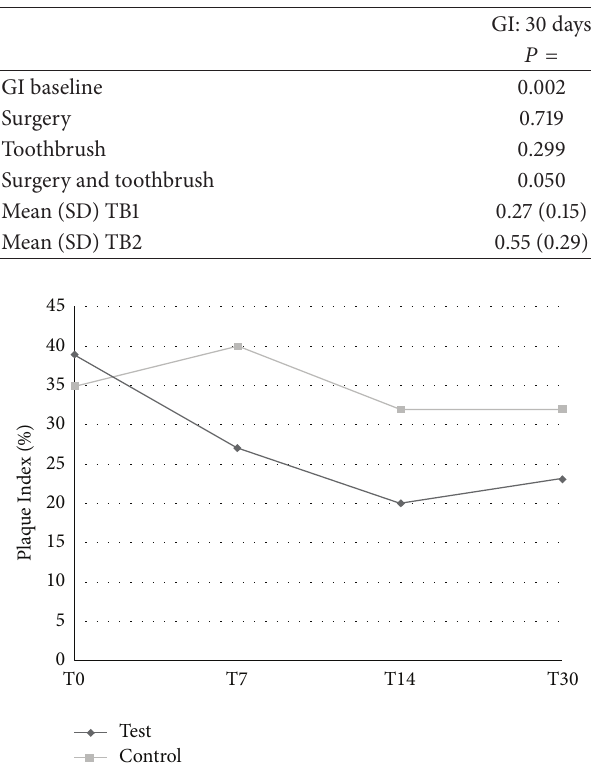
Table 2: Influence of the type of surgery (fixed factor) and of the toothbrush (random factor) on Gingival Index (GI) at 30 days. GI mean values and Standard Deviation (SD) are reported for both test (TB1) and control toothbrushes (TB2). Generalized Linear Model applied considering GI at baseline as covariate.